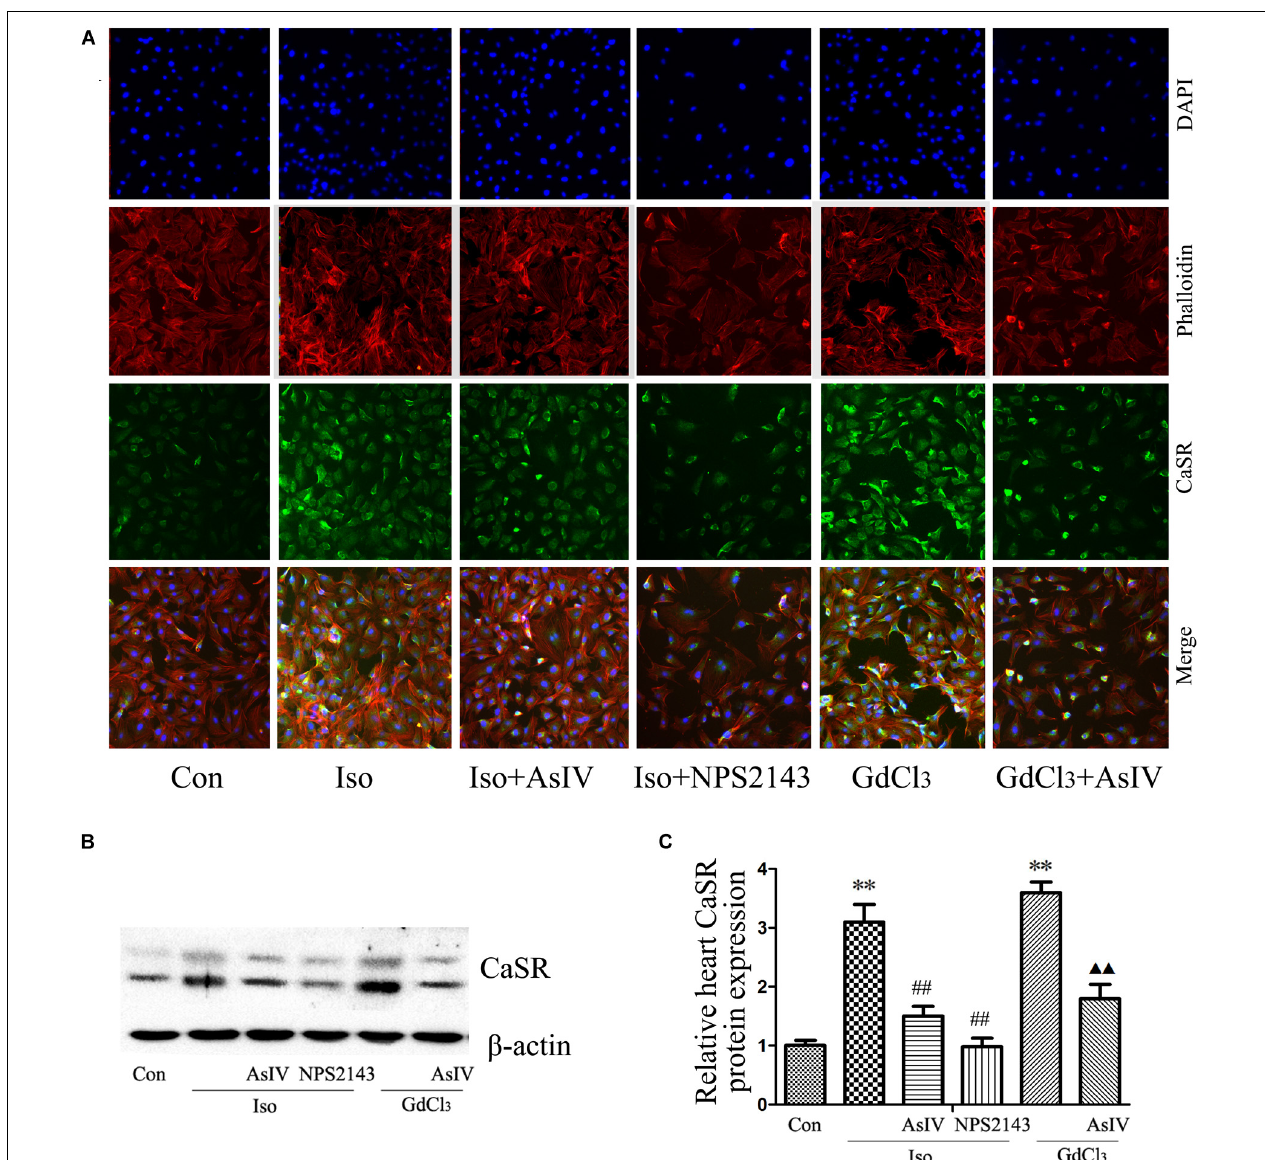
FIGURE 5 | AsIV decreased CaSR expression in heart tissue and cells. (A) The H9C2 cells were incubated with a CaSR antibody overnight at 4 ◦ C, incubated with fluorescein isothiocyanate (FITC)-conjugated goat anti-rabbit secondary antibody, and then treated with rhodamine-labeled phalloidin and DAPI. The cells were examined and photographed using a fluorescence microscope. (B,C) CaSR protein expression as assayed by western blot in myocardial tissue. The data are expressed as the means ± SEM, n = 4. ∗∗ P < 0.01 vs. the Con group; ## P < 0.01 vs. the Iso group; and (cid:78) P < 0.05, (cid:78)(cid:78) P < 0.01 vs. the GdCl 3